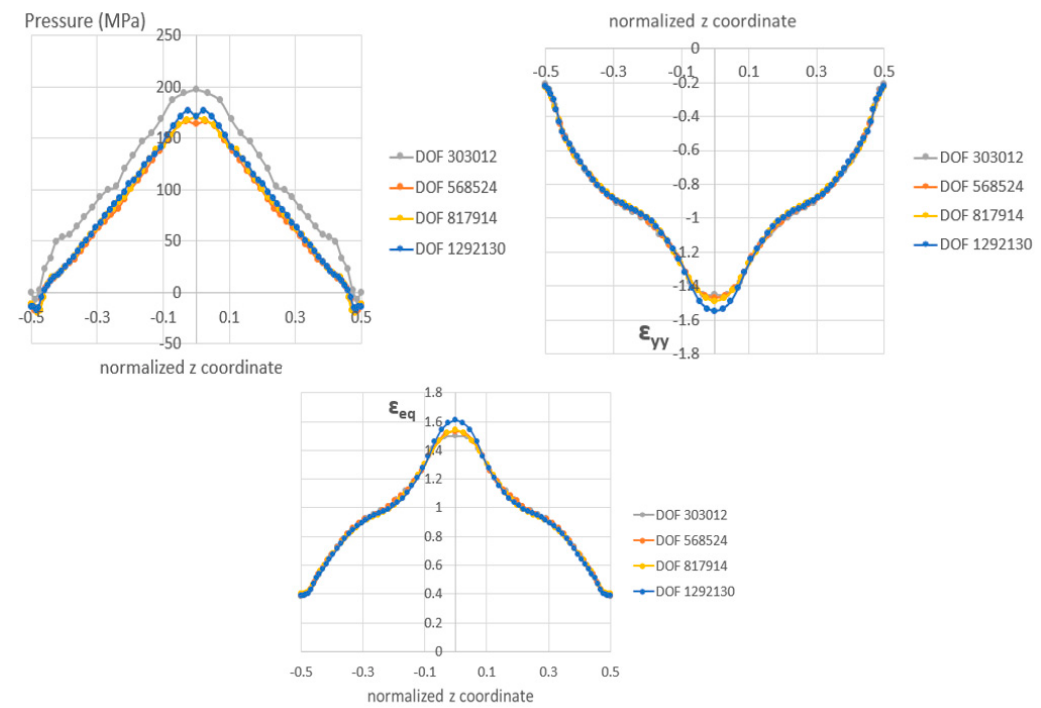
Figure A2. An example of a convergence test for the case of compression at 400 °C to 56% reduction. Here, for the chosen mass scaling value of 100,000, the mechanical fields (pressure—top, ε yy—middle, and ε eq—bottom) are examined for different degrees of mesh refinement .